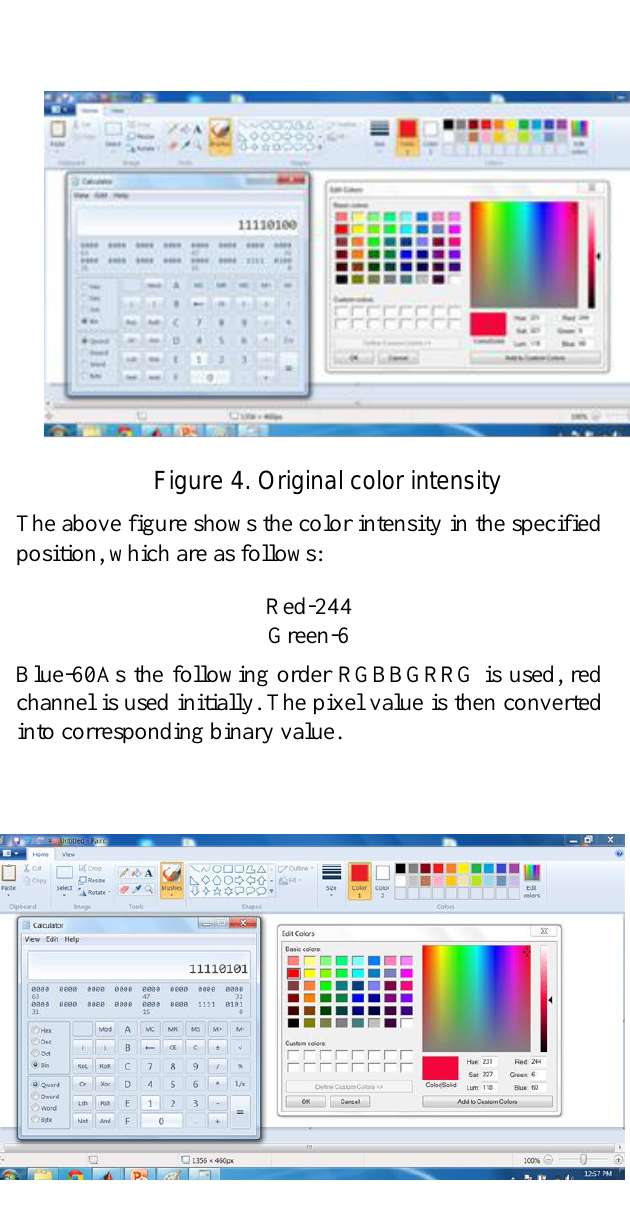
Figure 5. Altered color